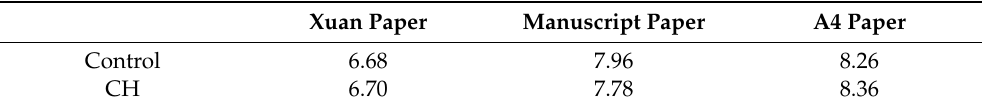
Table 4. The pH of papers before and after treatment with